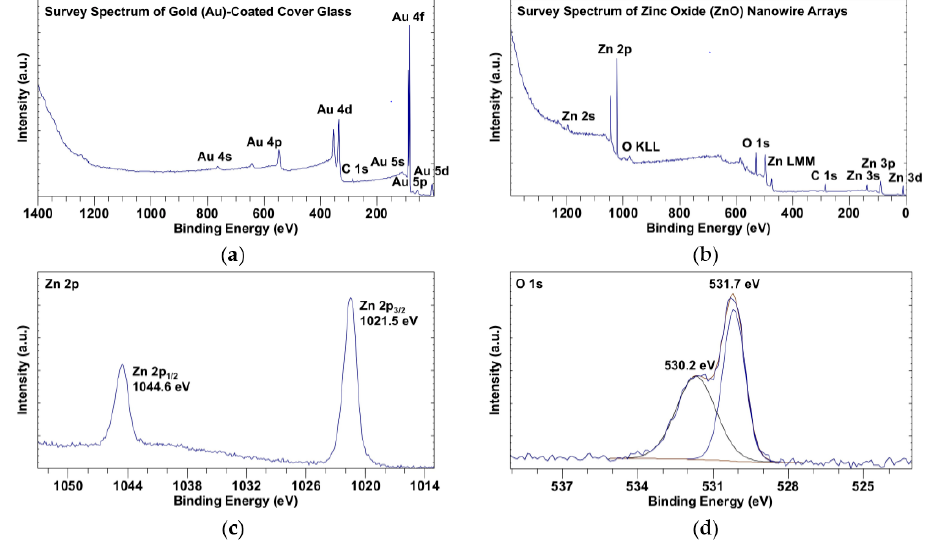
Figure 2. X-ray photoelectron spectroscopy (XPS) spectra of Au-coated cover glass and ZnO nanowire arrays: ( a ) survey spectrum of Au-coated cover glass; ( b ) survey spectrum of ZnO nanowire arrays; ( c ) Zn 2p spectrum of ZnO nanowire arrays; ( d ) deconvoluted O 1s spectrum of ZnO nanowire arrays. Table 1. Percentage atomic concentrations of regions and components detected on the surface of ZnO nanowire arrays by X-ray photoelectron spectroscopy (XPS).